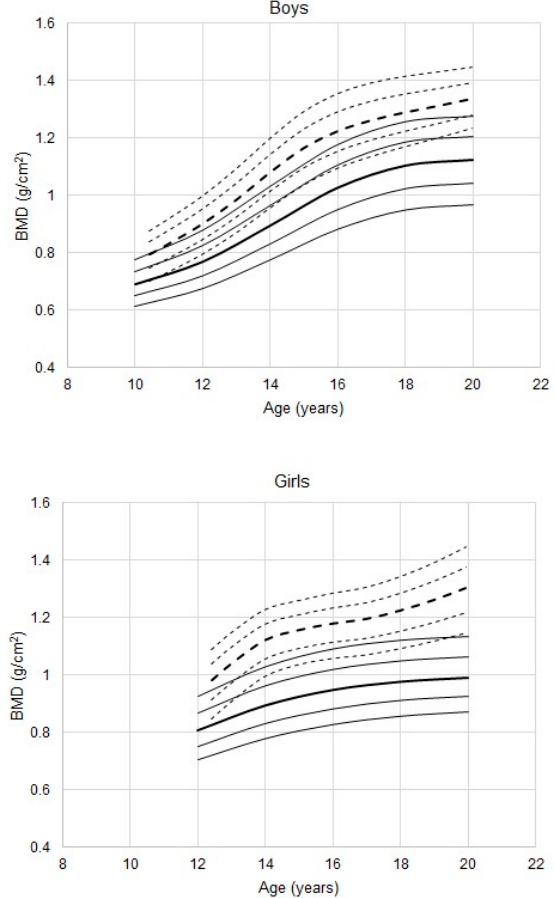
Figure 2. Total body less head (TBLH) BMD in youth male and female athletes 11 to 20 years of age; percentiles (- - -) for athletes, estimated with the LMS method, are plotted relative to the DEXA reference (—) percentiles (10th, 25th, 50th, 75th, 90th; the 50th percentiles are in bold). Percentiles for BMC among male athletes are also consistently higher than those of the reference (Figure 3, p < 0.001 in all age groups). The medians for athletes approximate the 90th percentiles of